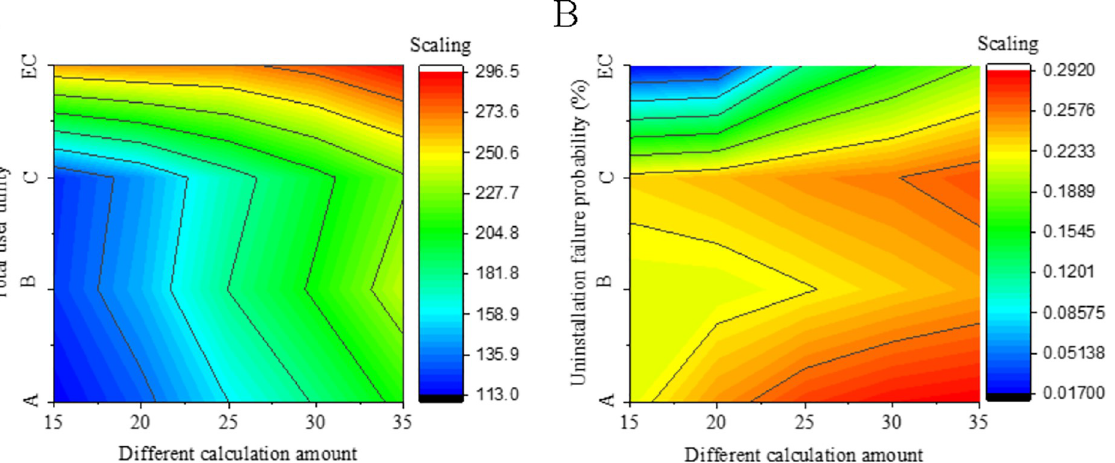
Fig 6. User utility and uninstallation failure under different